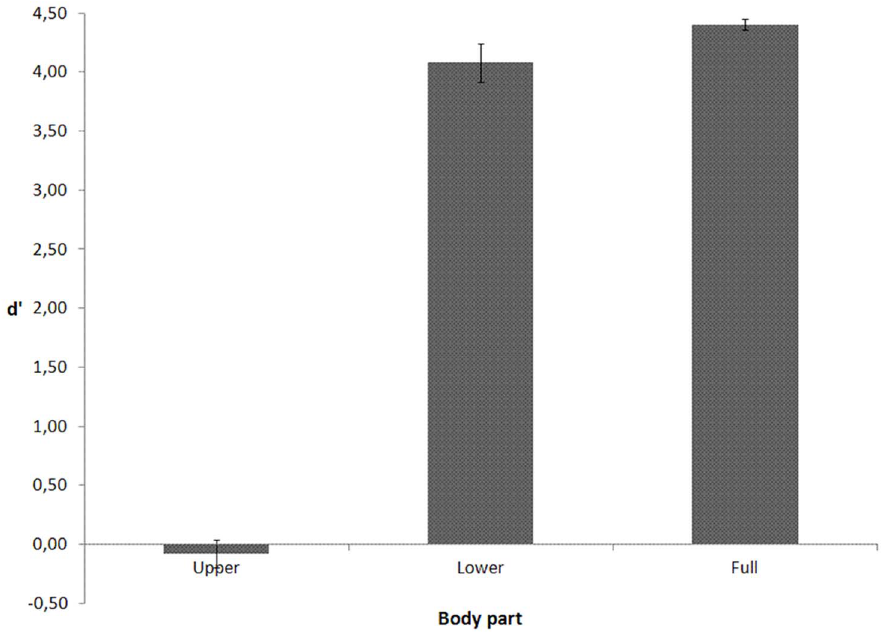
Fig. 1. d’ (including standard error bars) as a function of visible body part for the walking action in Experiment 1.